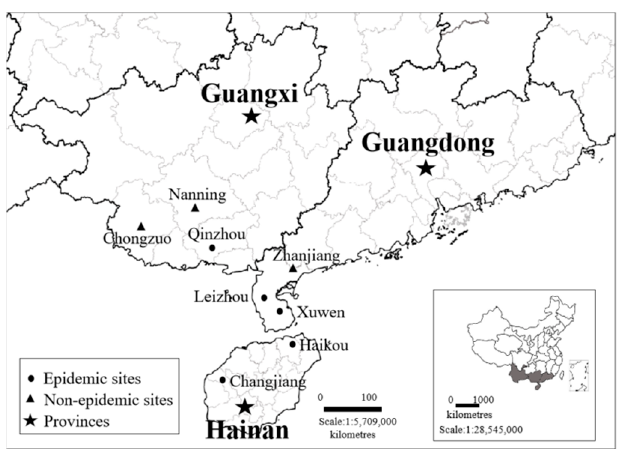
Figure 6. Location of sample collection sites in south China between 2018 and